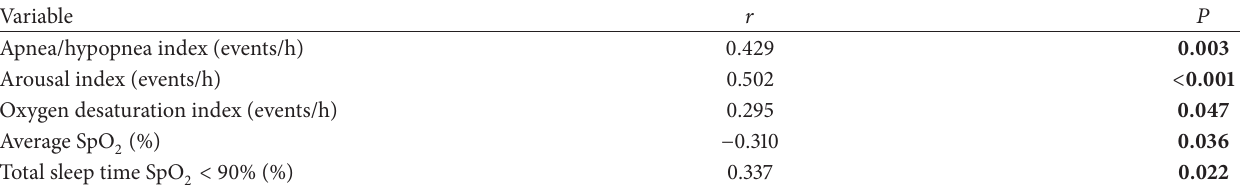
Table 3: Correlation coefficients between neutrophil reactive oxygen species and polysomnographic parameters in obstructive sleep apnea patients.